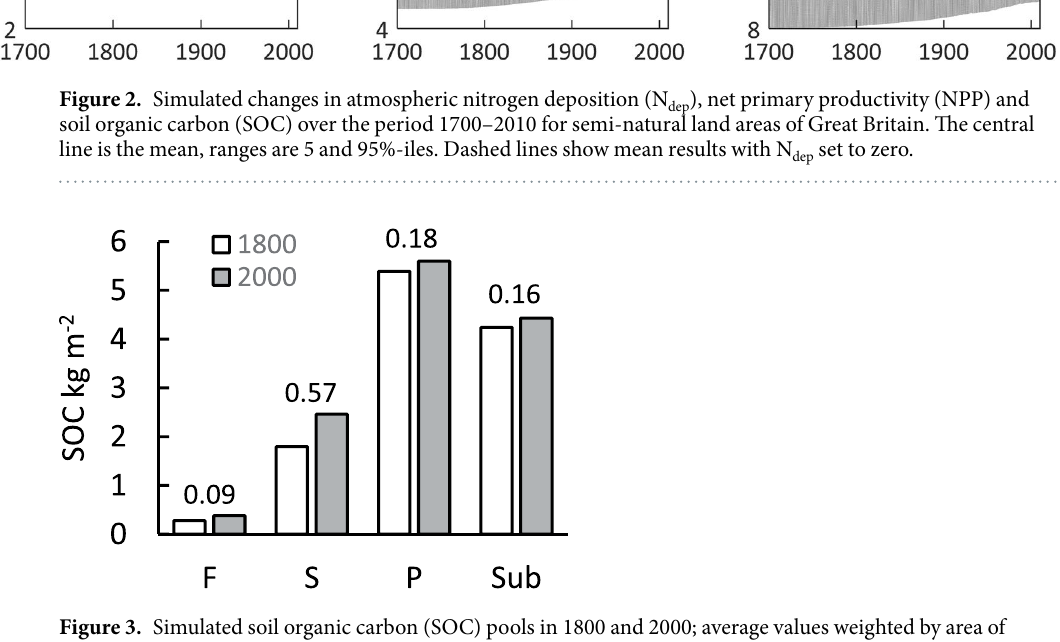
Figure 3. Simulated soil organic carbon (SOC) pools in 1800 and 2000; average values weighted by area of broadleaf woodland, grassland, and shrubland in Great Britain. Key: fast (F, mean residence time 1 yr), slow (S, c. 20 yr), passive (P, c. 1000 yr) and subsoil (Sub, c. 2000 yr). The values above the pairs of bars show the fractional contributions to the total increase in